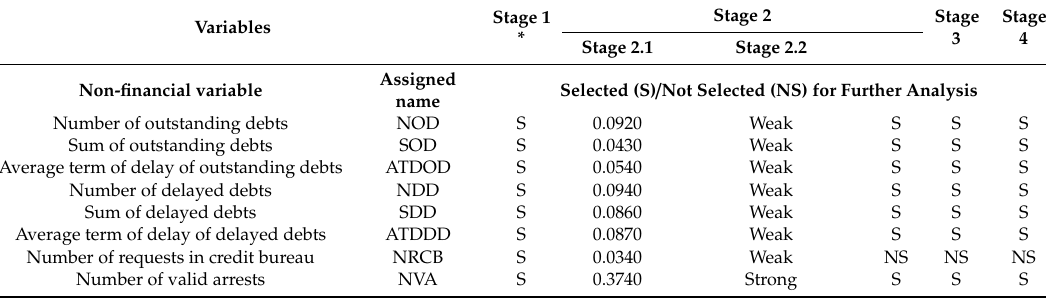
Table A3. Inclusion of variables into logistic regression model for